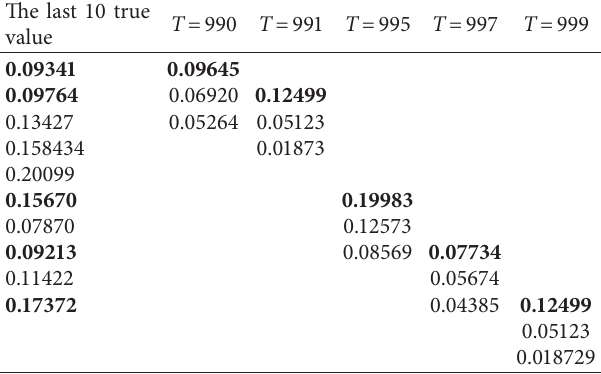
Figure 20: The validation of volatility for T � 1000. Table 11: 3 days ahead volatility prediction analysis of the fuzzy- EGARCH-ANN